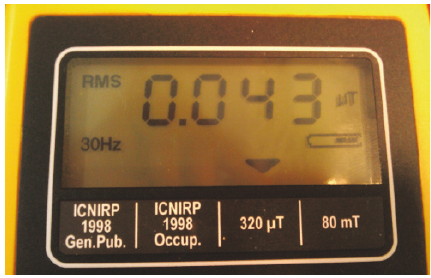
Figure 5: Outline of the double loop constructed.